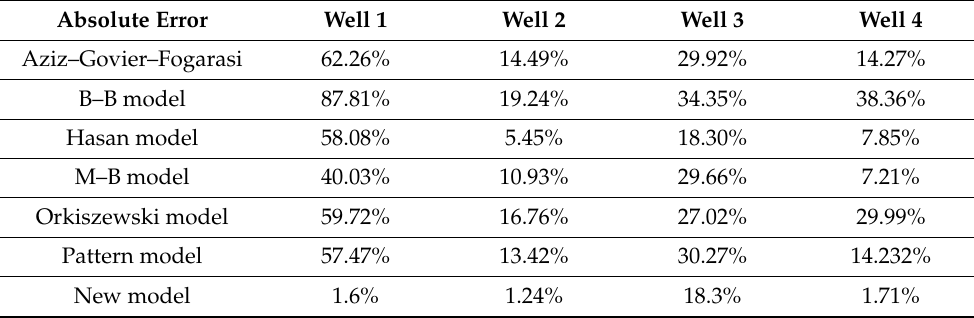
Figure 24. Different pressure calculation methods applied to the No. 4 well of the Donghai gas field. The errors between different models are shown in Table 6. Table 6. Comparison of calculation errors of different